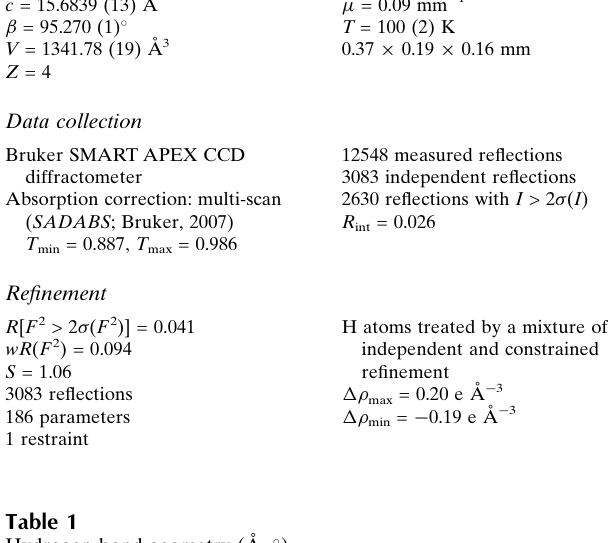
Hydrogen-bond geometry (A˚ , (cid:2)